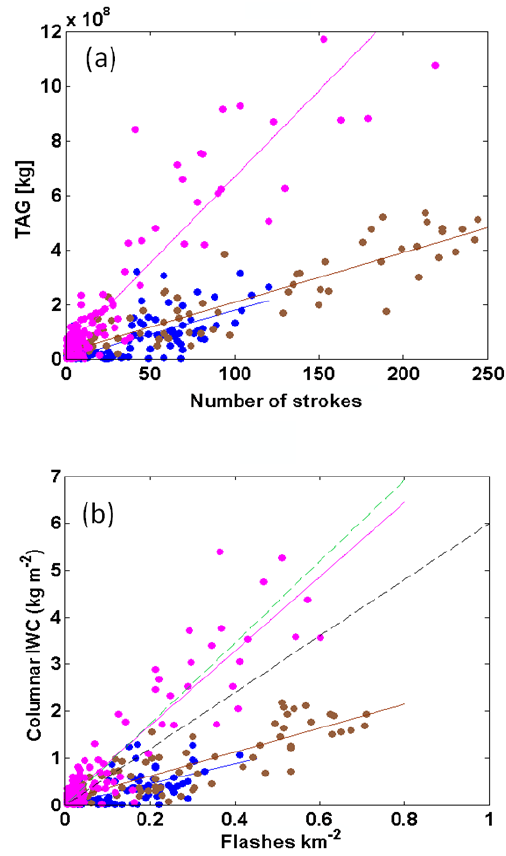
Figure 8. (a) The total number of strokes detected (in 5min) by LINET in the Polar 55C coverage area in relation to TAG (com- puted every 5min) on 13 September 2012 (blue), 12 October 2012 (brown), and 15 October 2012 (magenta); (b) flash density in rela- tion to the mean columnar IWC g (each computed every 5min for the same days). All points for each day are fitted with linear regres- sion (solid line). In (b) the black dashed line is the threshold found by FO13 and the green dashed line is the linear relation found by PE05 over land.